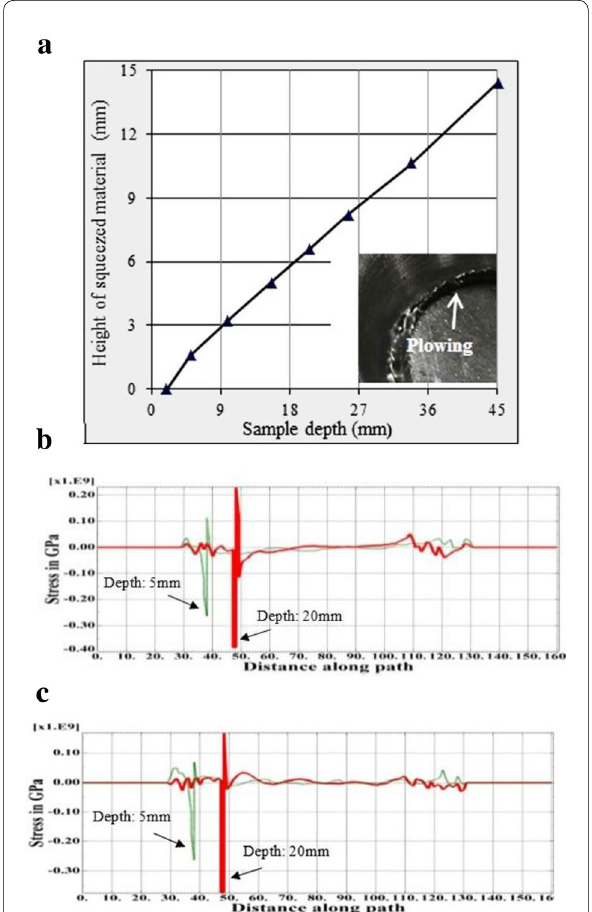
Figure 6 Selected results for a sample formed with the tool-radius of 1.1 mm: (a) Progression of squeezed material; (b) X - stress for two depths of sample; and (b) Y - stress for two depths of sample